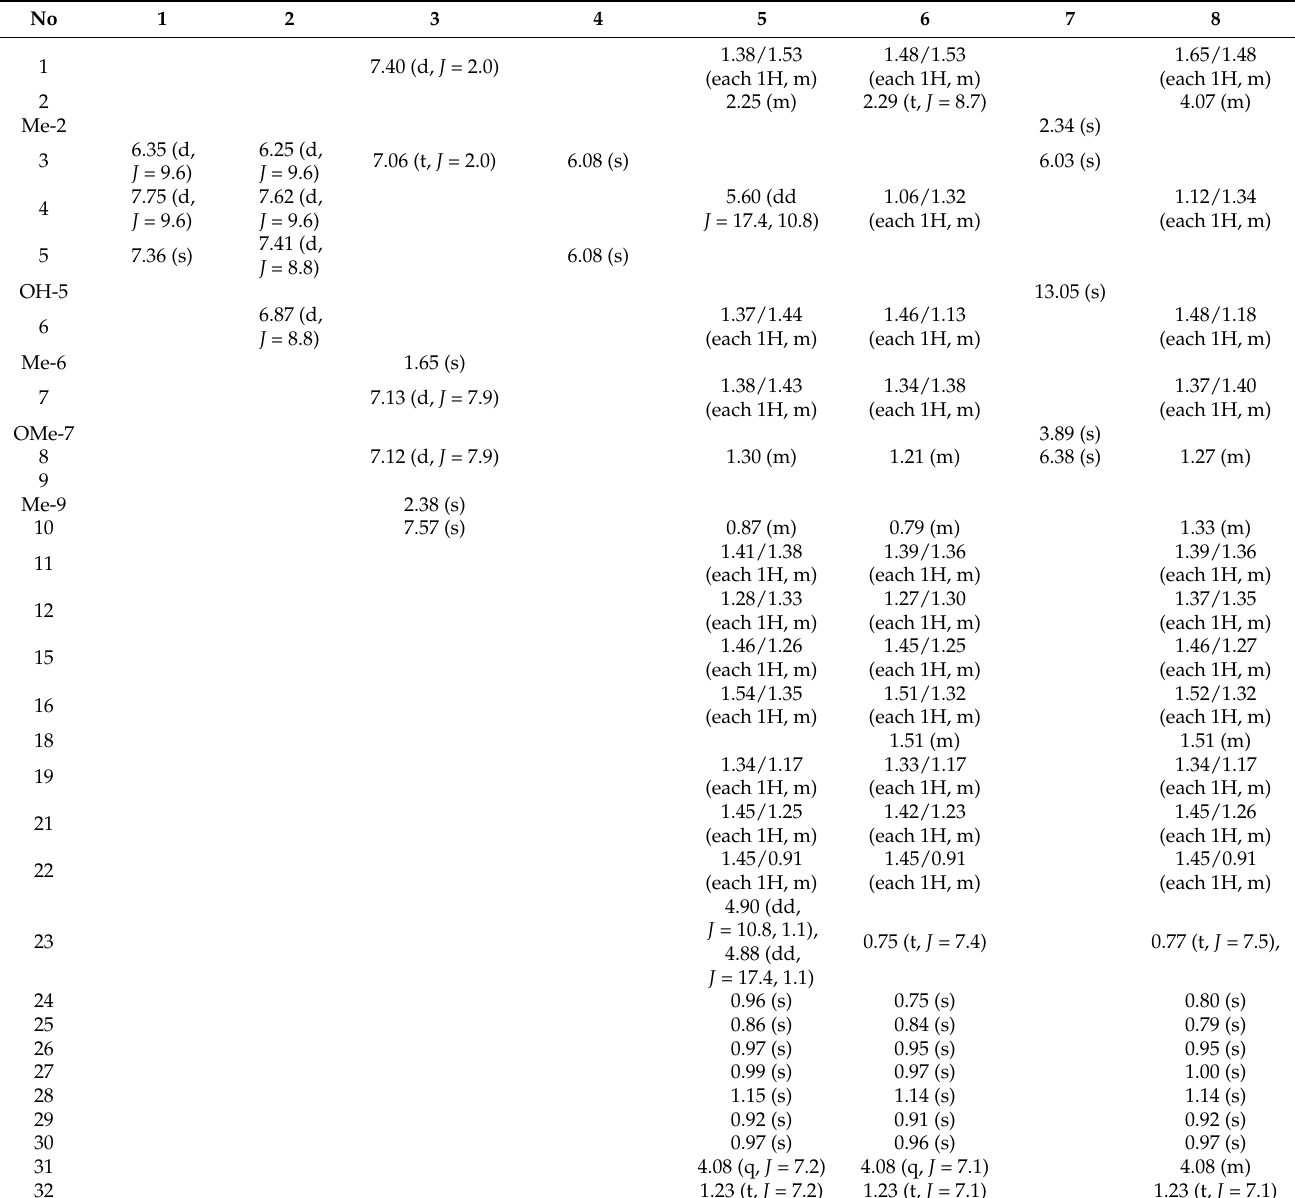
Table 1. 1 H NMR data for Compounds 1 – 8 in CDCl 3 ( δ in ppm, J in Hz, 500 MHz in CDCl 3